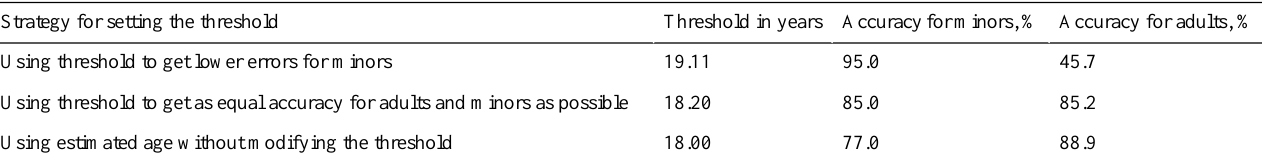
Table 5. Accuracies for minor versus adult classification of female